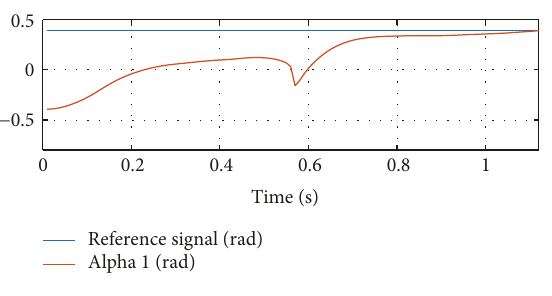
Figure 20: Trajectory of 𝛼 1 (rad).